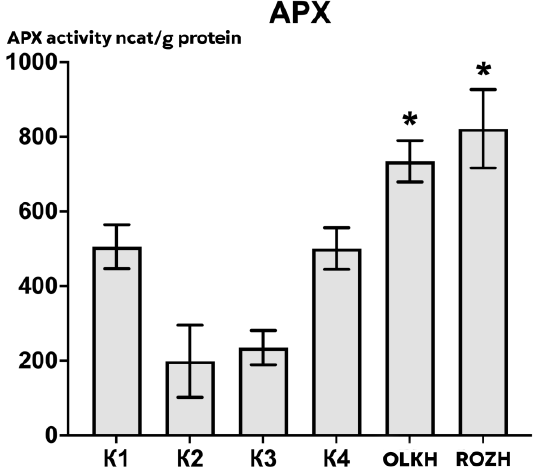
Figure 3. APX activity in tubers of H. tuberosus growing in contaminated arias and arias without contamination. * corresponds to p < 0.05 significance level.